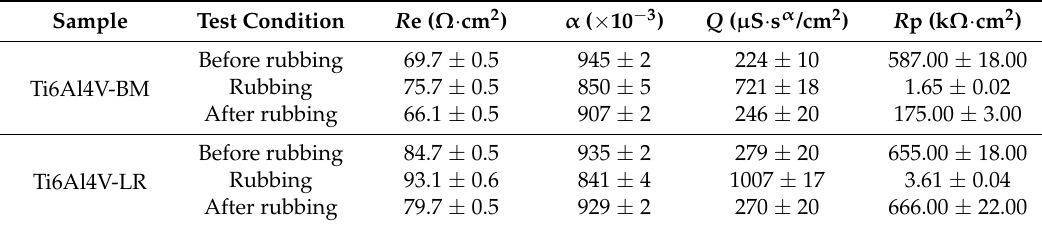
Figure 13. Electrochemical impedance spectroscopy represented as Nyquist diagrams: ( a ) before and ( b ) after loading. Table 4. Mean and standard deviation values of the fitted EIS